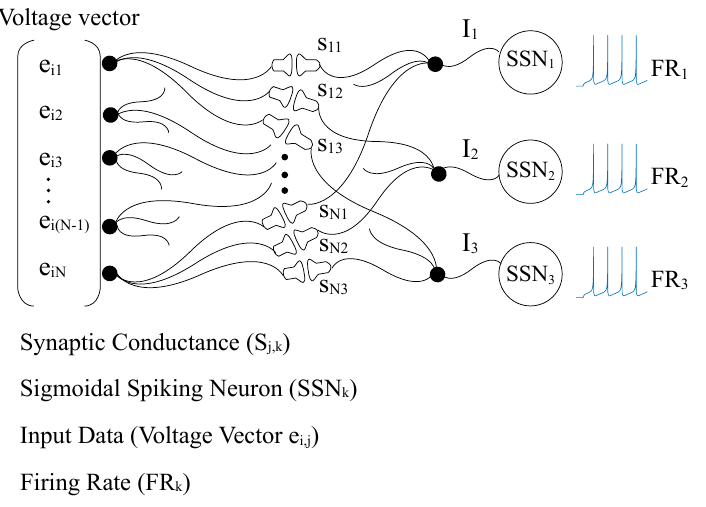
Figure 3. Spiking Neural Network Architecture.